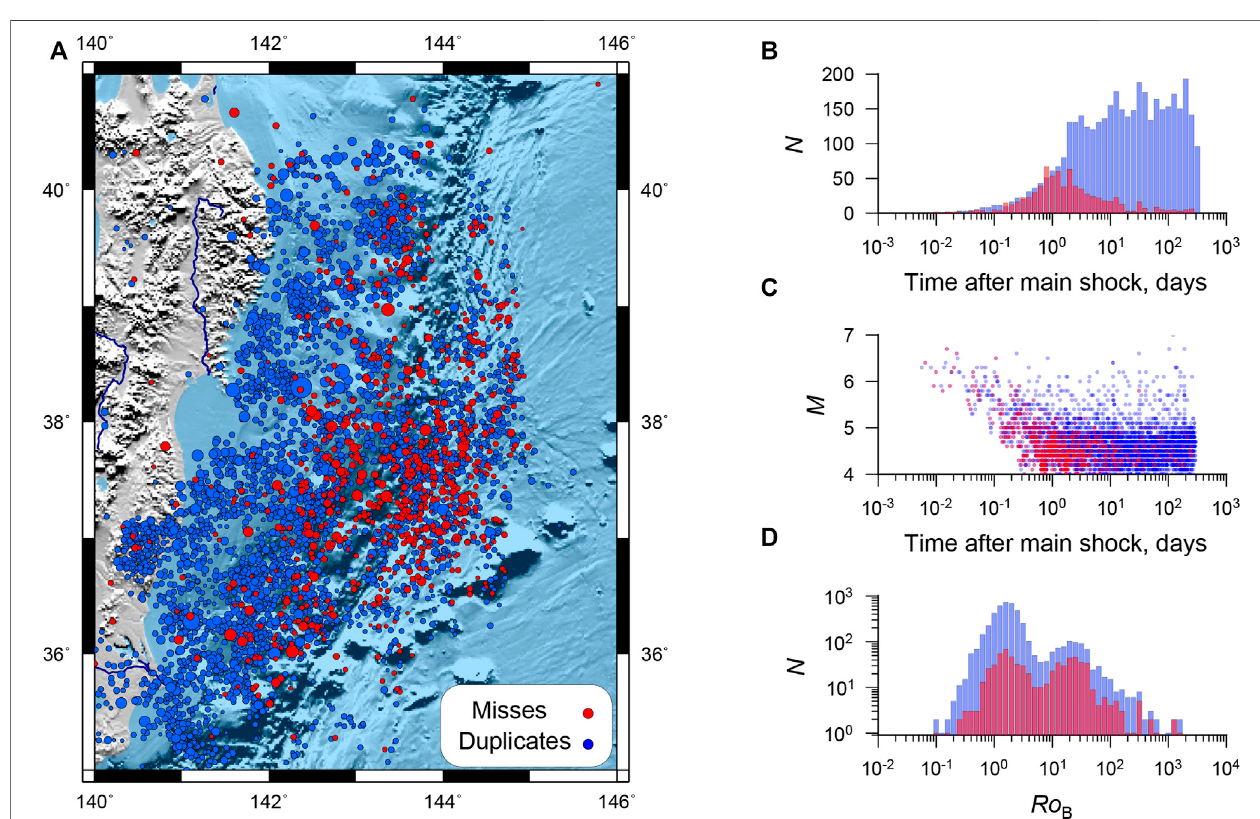
FIGURE 6 | JMA misses. (A) Tohoku Aftershock Epicenter Map (ANSS), red dots are JMA missed events. (B) Distribution in time of misses (red) and duplicates (blue). (C) Magnitude distribution ofmisses (red) andduplicates (blue)intime. (D) Comparison ofthe Ro B metricdistributionforJMA/ANSS pairs onthe fi rstdayafter the main shock (red) and for the entire studied period (blue).